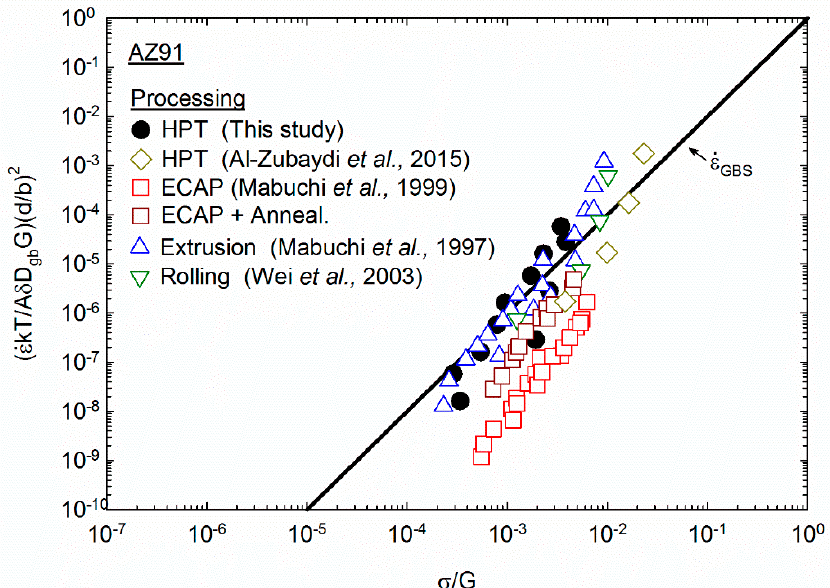
Figure 5. Strain rate normalized by effect of temperature and grain size, and plotted as function of stress normalized by shear modulus. Data from the literature [14,38,41,43] were also included. Different thermomechanical-processing operations introduced superplasticity in the AZ91 alloy. In Figure 5, data were collected from various processing methods, but the largest elongations were associated with processing by SPD. Thus, maximal elongations of 425% [43] and 455% [41] were reported after extrusion and rolling, respectively, whereas elongations of 956% [14] and 1308% [38] were reported after ECAP and HPT, respectively. The present results confirmed that SPD was the optimal processing technique to introduce superplasticity in this alloy, as elongations over 1000% were observed at 523 K at strain rates of 10 − 5 s − 1 and 10 − 4 s − 1 . Elongations over 400%, which is considered a limiting threshold for superplasticity, were also not reported at temperatures below 0.5 T m or at strain rates of 10 − 2 s − 1 or faster after extrusion or rolling. However, low-temperature